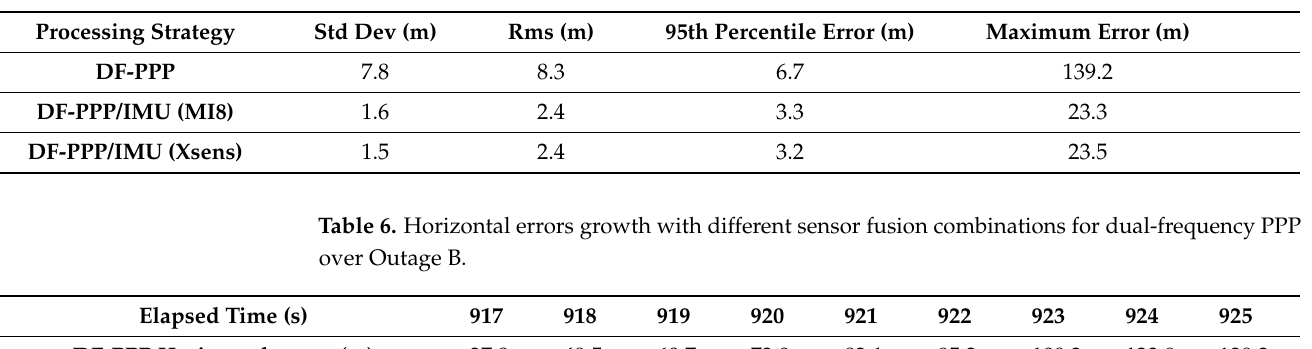
Table 5. Horizontal errors with different sensor fusion combinations for dual-frequency PPP processing.